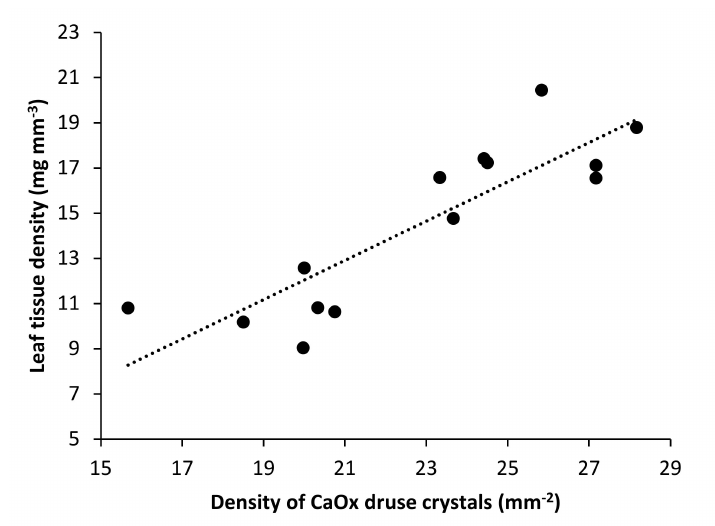
Figure 6. Regression graph showing strong positive relationship between leaf tissue density and density of CaOx druse crystals.